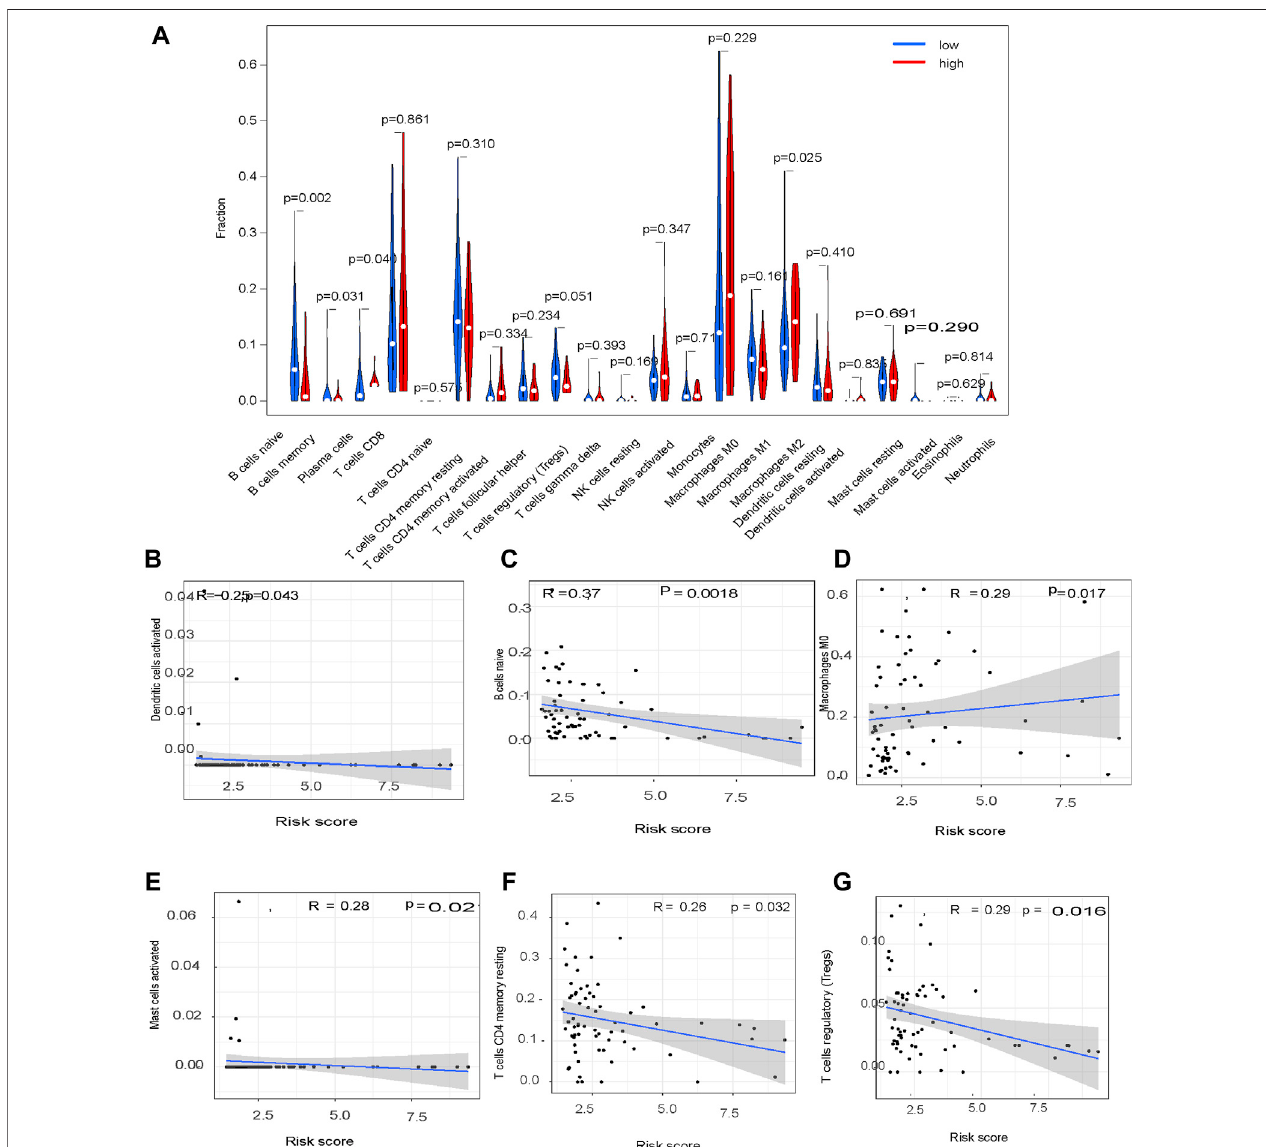
FIGURE 9 | Tumor in fi ltration immune cell pro fi